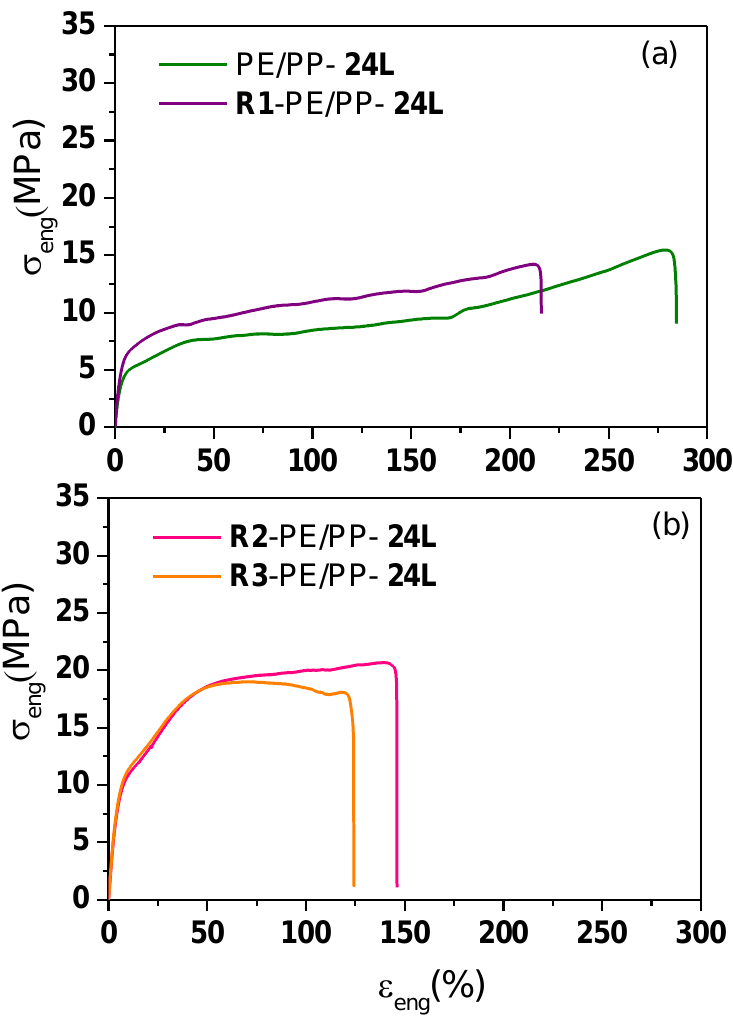
Figure 4. Engineering stress-strain plot of the recycled PP/LLDPE/PP-24L multilayer films (MD) obtained from different recycling processes: ( a ) R1 and ( b ) R2 and R3. Table 4. Ensile strength properties in the machine direction of the recycled PP/LLDPE/PP-24L multilayer films following different recycling